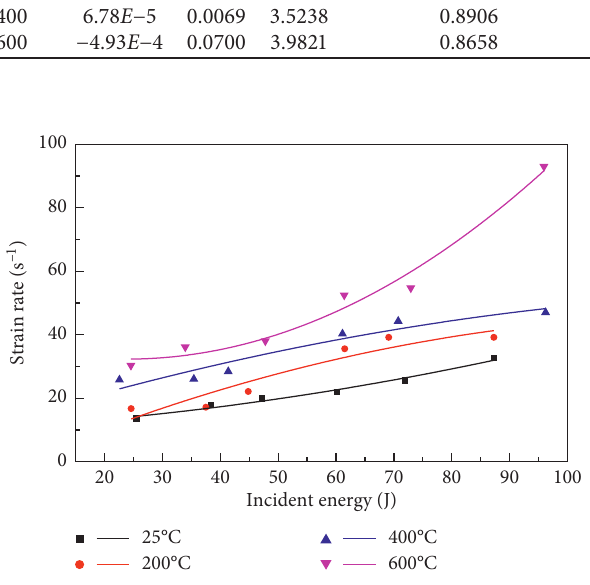
Figure 14: Relationship between strain rate and incident